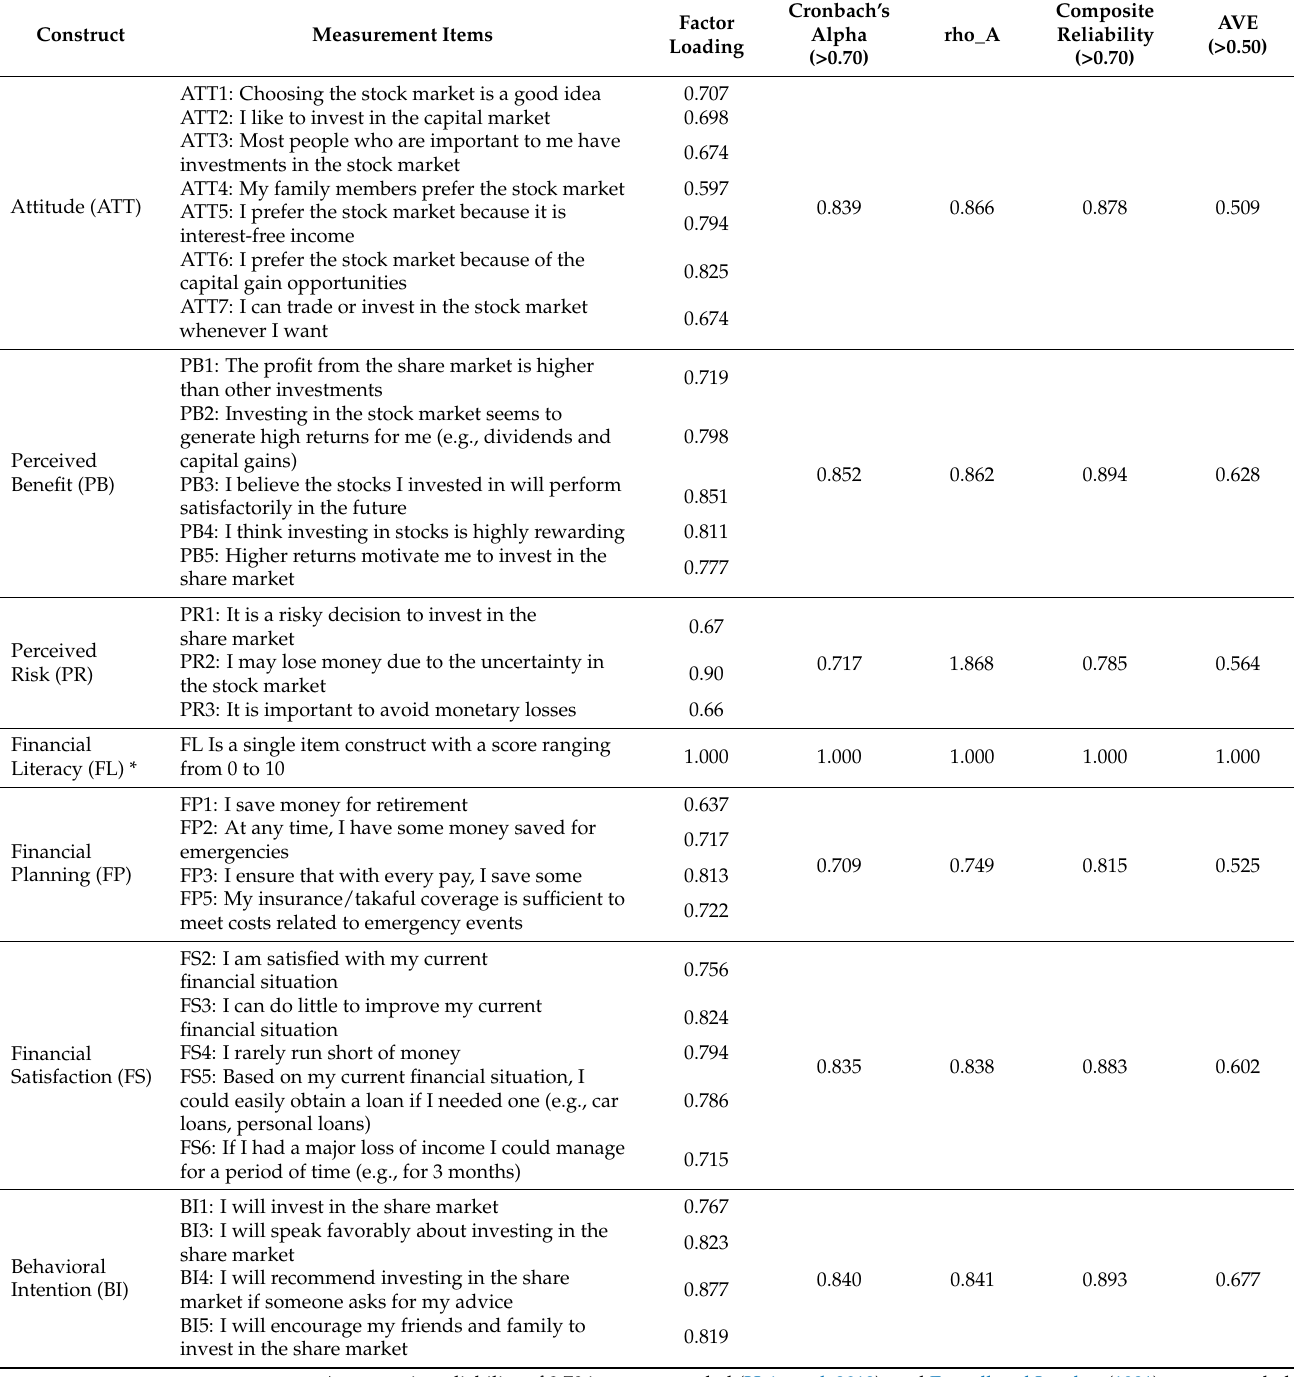
Table 2. Construct measurement items, reliability, and